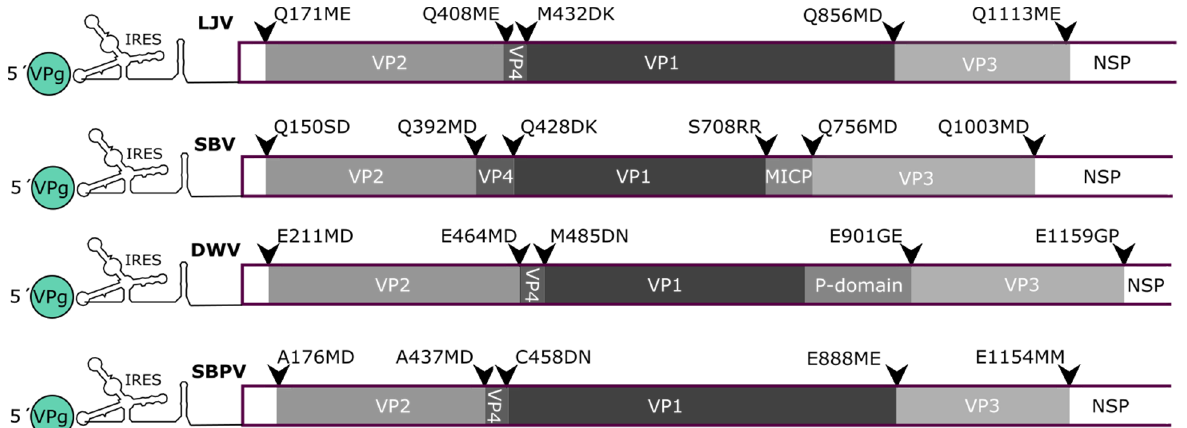
Figure 9. Organization of the structural protein region of different iflavirus polyproteins. We compared the sequences of La Jolla virus (LJV) to sacbrood virus (SBV), deformed wing virus (DWV) and slow bee paralysis virus (SBPV). The map shows the 5 ′ -UTR (including the IRES element and the VPg protein as a green circle), the leader protein (white bar) and the capsid proteins VP2, VP4, VP1 and VP3 in grayscale. The unusual minor capsid protein (MICP) from SBV, corresponding to the processed protrusion (P) domain present in DWV, is also shown. The start of the non-structural protein region (NSP) is indicated in white. Arrowheads mark cleavage sites, which are similar between LJV and SBV.